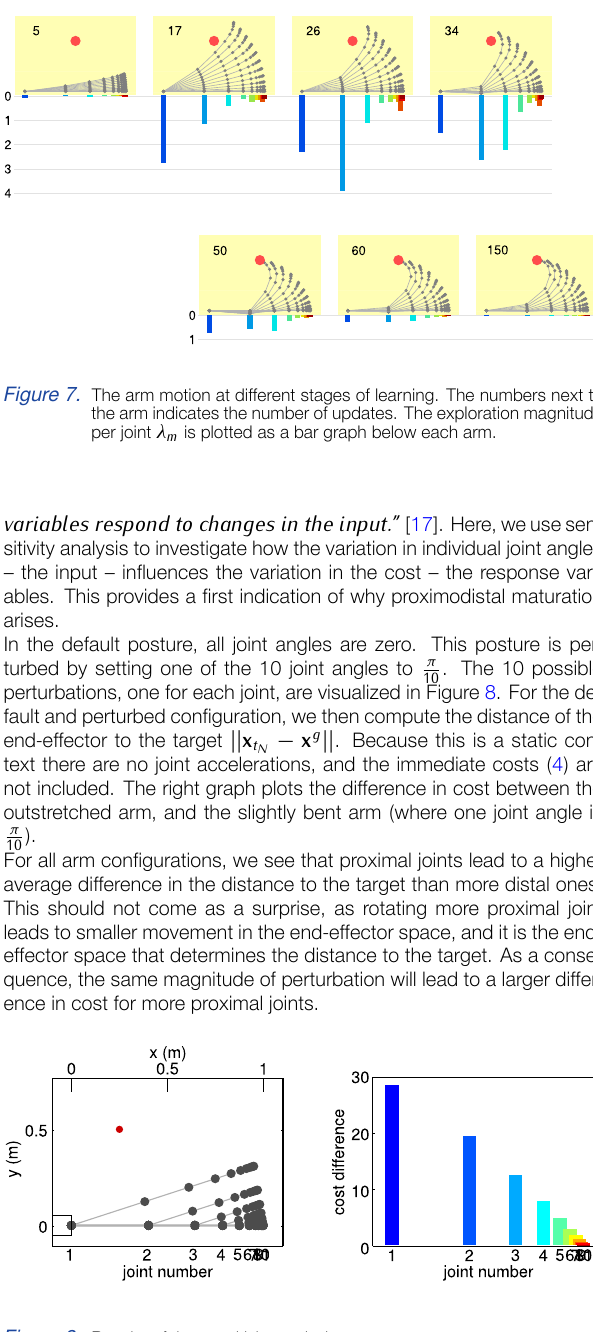
Figure 8. Results of the sensitivity